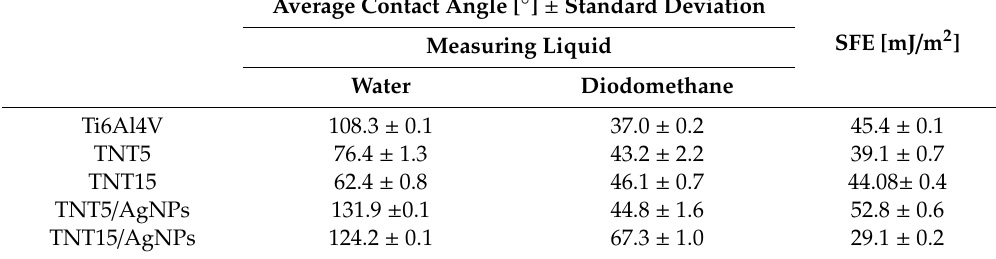
Table 3. Results of the wetting angle measurements and results of the surface free energy (SFE) measurements of the